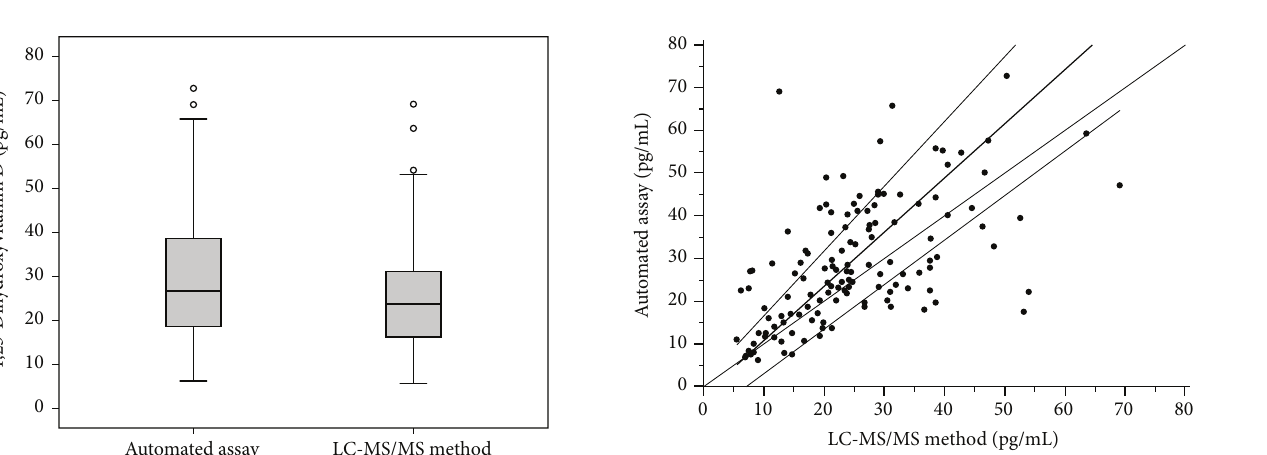
Figure 1: Box and whisker plots showing the distribution of results for the automated assay and the LC-MS/MS method. The central boxes express the upper and lower quartile, and the central lines showthemedian.Thewhiskersrepresentthevaluesbelowandabove the interquartiles, excluding outliers. Outliers (circles) are defined as values that exceed the upper and lower quartile plus or minus 1.5 times the interquartile range.